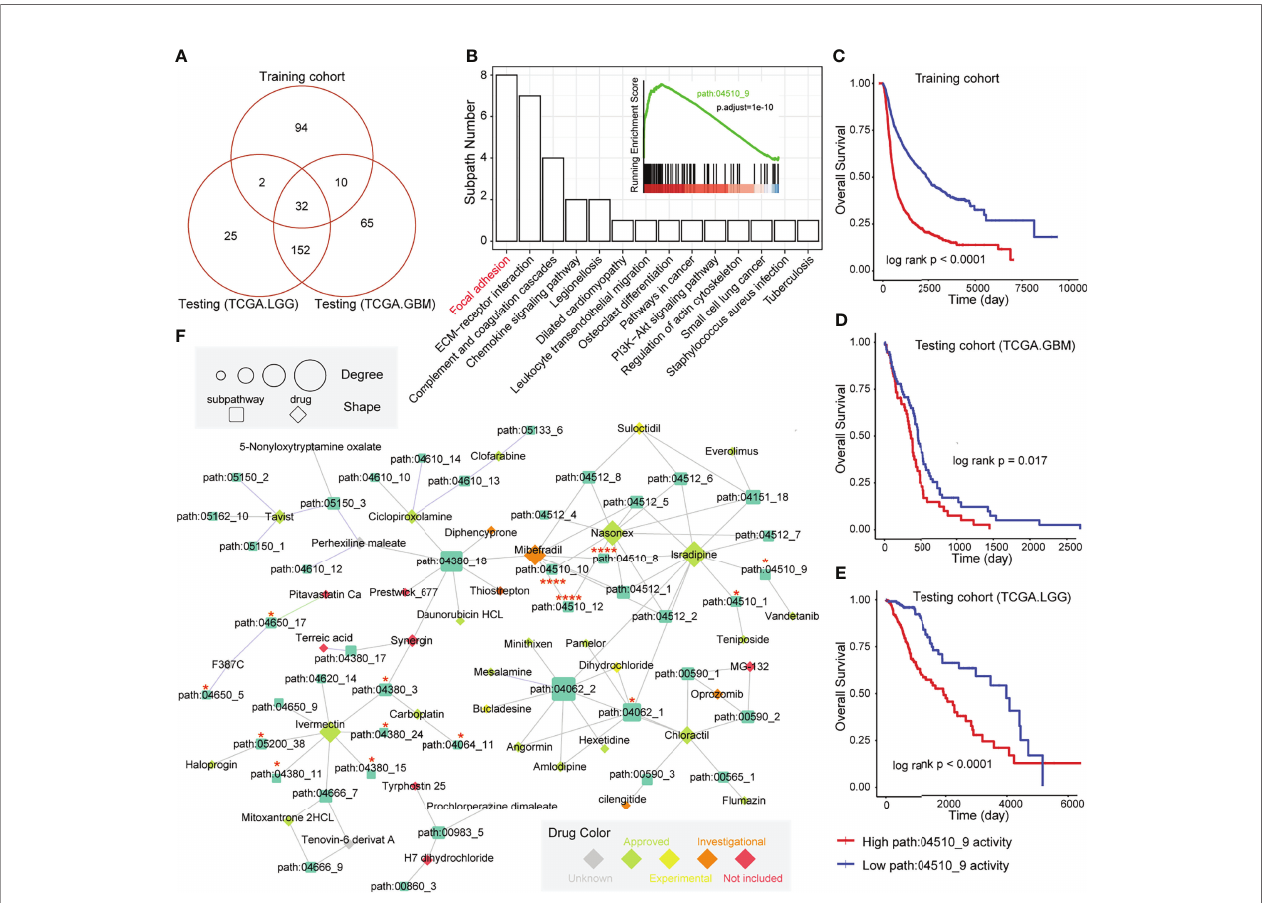
FIGURE 6 | Subpathway-level functional exploration and drug – subpathway network. (A) Venn diagram of risk subpathways from training cohorts, testing TCGA- GBM cohorts, and TCGA-LGG cohorts. The risk subpathways were identi fi ed using the GSEA method based on the high and low GMEFS groups from the three cohorts. (B) The subpathway number statistics for 32 risk subpathways shared by the three cohorts. The Kaplan – Meier survival curves according to the activity value of one subpathway (path:04510_9) in the training cohort (C) , testing TCGA-GBM cohort (D) , and testing TCGA-LGG cohort (E) . (F) The drug subpathway network. The network shows the subpathways (squares) that could be targeted by drugs (diamonds) based on three levels of omics data from the HGCC database. The color of the drug indicates the fi ve drug classes from the HGCC resource. The size of the subpathways or drugs increases with the degree that re fl ects the associations between the drugs and regulated